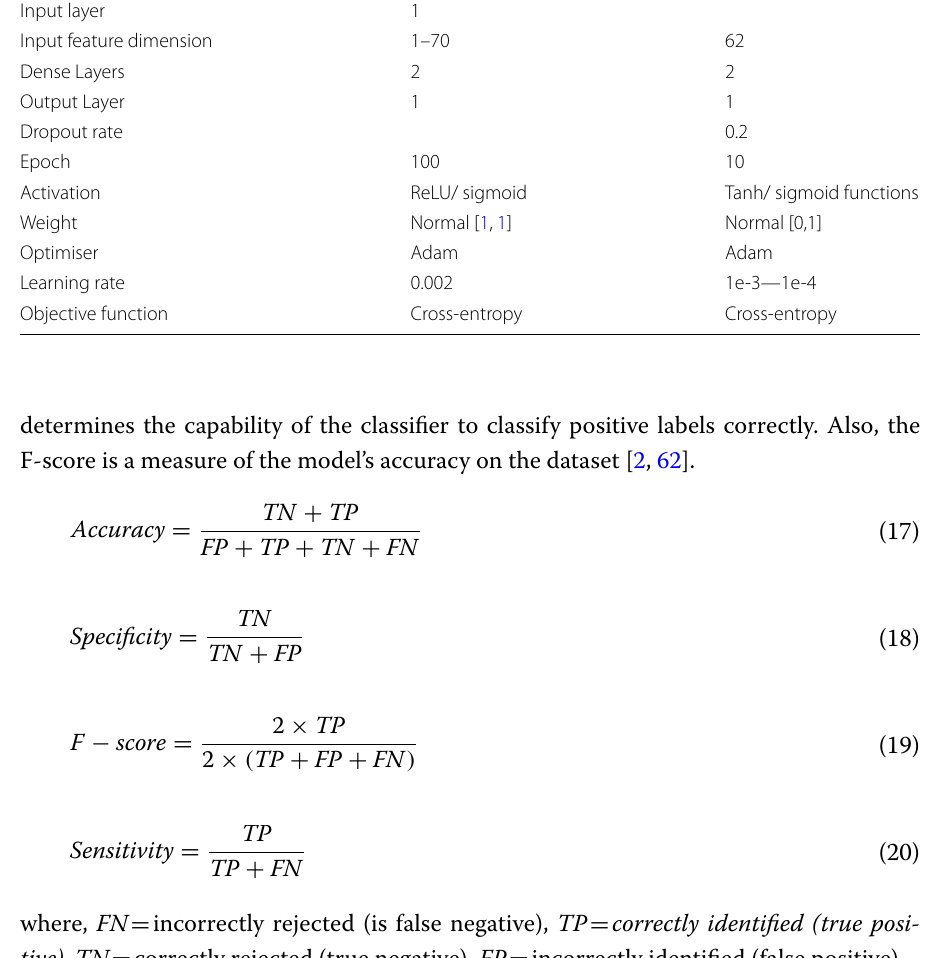
Table 3 A summary of study hyperparameters